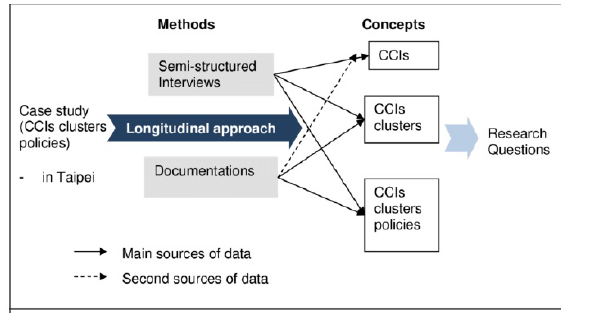
Fig. 6 Data collector structure